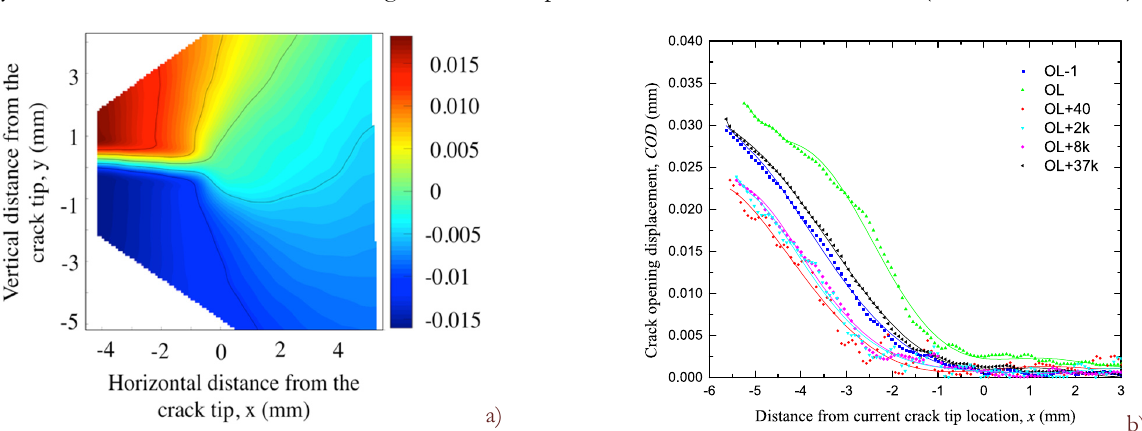
Figure 4: DIC analysis showing the a) vertical displacement field V y (in mm) between 1.7K max (OL) and at K min prior to OL, b)